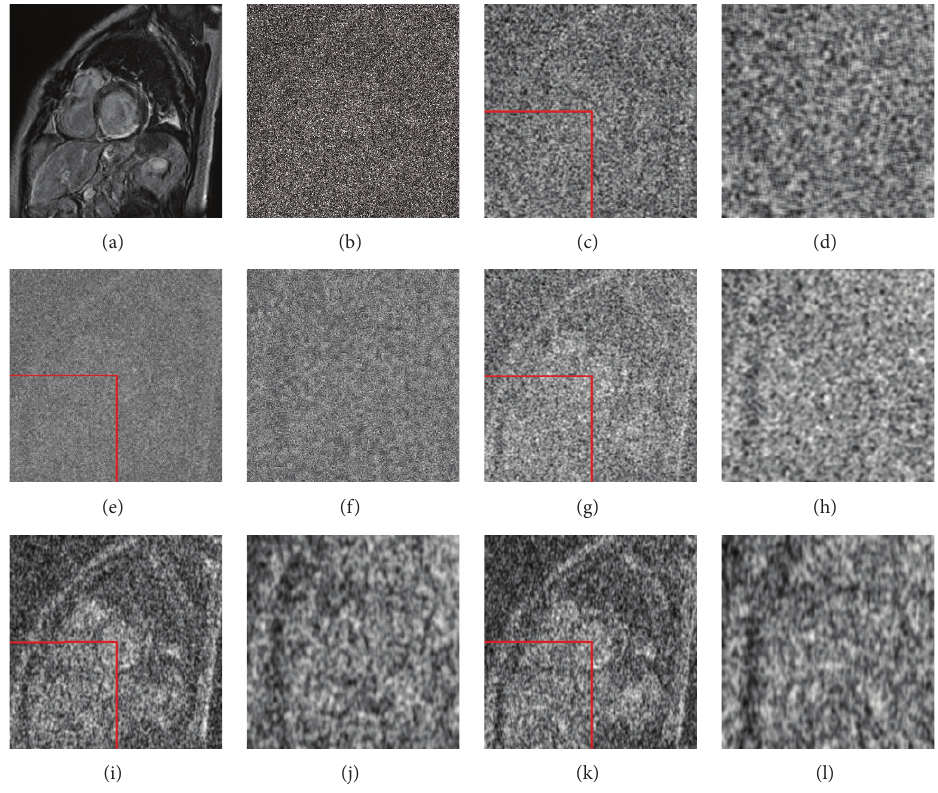
Figure 6: Denoising effects of abdomen MRI of texture-rich internal organ, when Gaussian noise is very strong. (a) Original clean MRI, (b) noisy image (adds white Gaussian noise to the original clean MRI, PSNR = 5.4389 ), (c) denoised image of bilateral filtering denoising [88, 89, 93], (d) partial enlarged details of 1/4 party of (c) red box, (e) denoised image of wavelet denoising [88, 91], (f) partial enlarged details of 1/4 party of (e) red box, (g) denoised image of NLMF denoising [94, 95], (h) partial enlarged details, 1/4 party of (g) red box, (i) denoised image of FDM denoising ( V 1 = 1.75 , V 2 = 2.75 , V 3 = 1.05 , Δ𝑡 = 5 × 10 −6 ), (j) partial enlarged details of 1/4 party of (i) red box, (k) denoised image of FDM denoising ( V 1 = 2.25 , V 2 = 2.5 , V 3 = 1.25 , Δ𝑡 = 5 × 10 −6 ), and (l) partial enlarged details of 1/4 party of (k) red